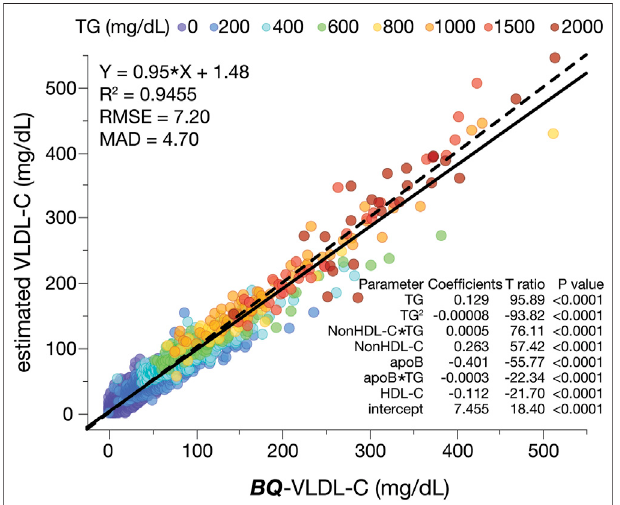
FIGURE 2 | Development of the enhanced VLDL-C equation ( eS -VLDL- C). The training dataset (N = 12,141) was used in multiple regression analysis with the indicated input variables. The solid line is the linear fi t for indicated regression equation. A dashed line is the line of identity. Results are color-coded by TG levels with the value in the legend indicating the start of each interval.